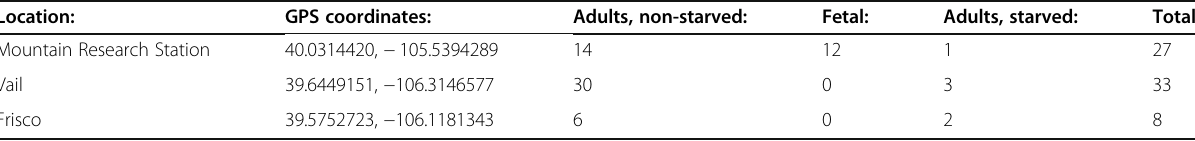
Table 1 Breakdown of sampled snails and their associated locations and treatment groups Location: GPS coordinates: Adults, non-starved: Fetal: Adults, starved: